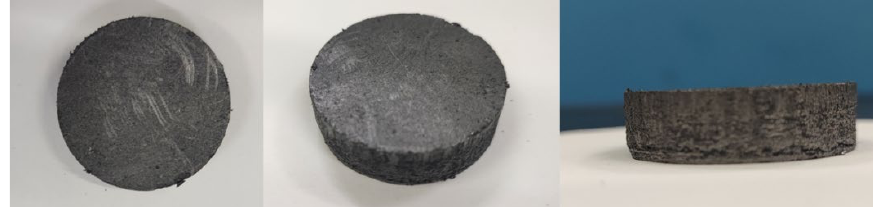
Figure 2. Photos of n-tetradecane/EG composite.